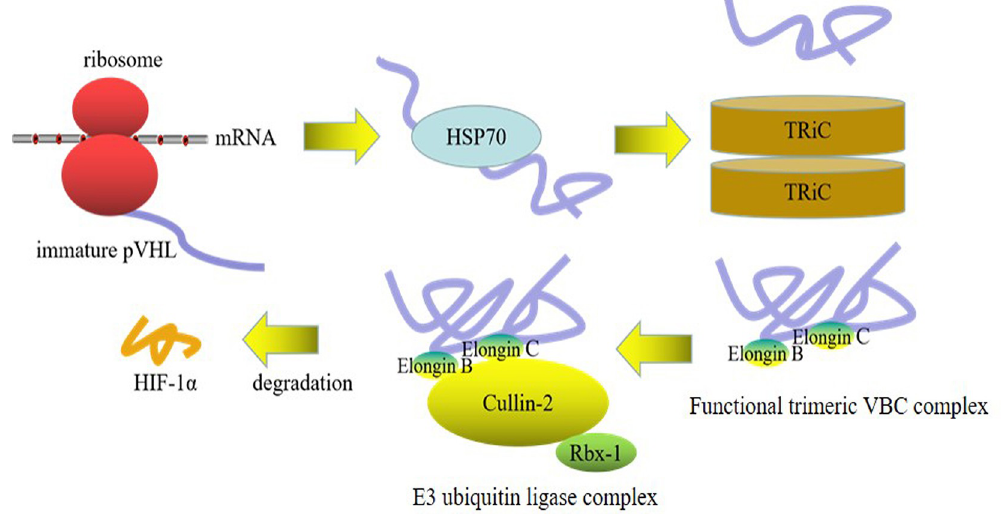
Fig 11. Sequential assembly of VBC complex in HIF-1 α degradation. Chaperone HSP70 cooperates with TRiC in correct folding of newly translated pVHL in a sequential manner, which is latter coupled to the assembly of trimeric VBC complex (pVHL-Elongin BC) and mediates degradation of HIF-1 α